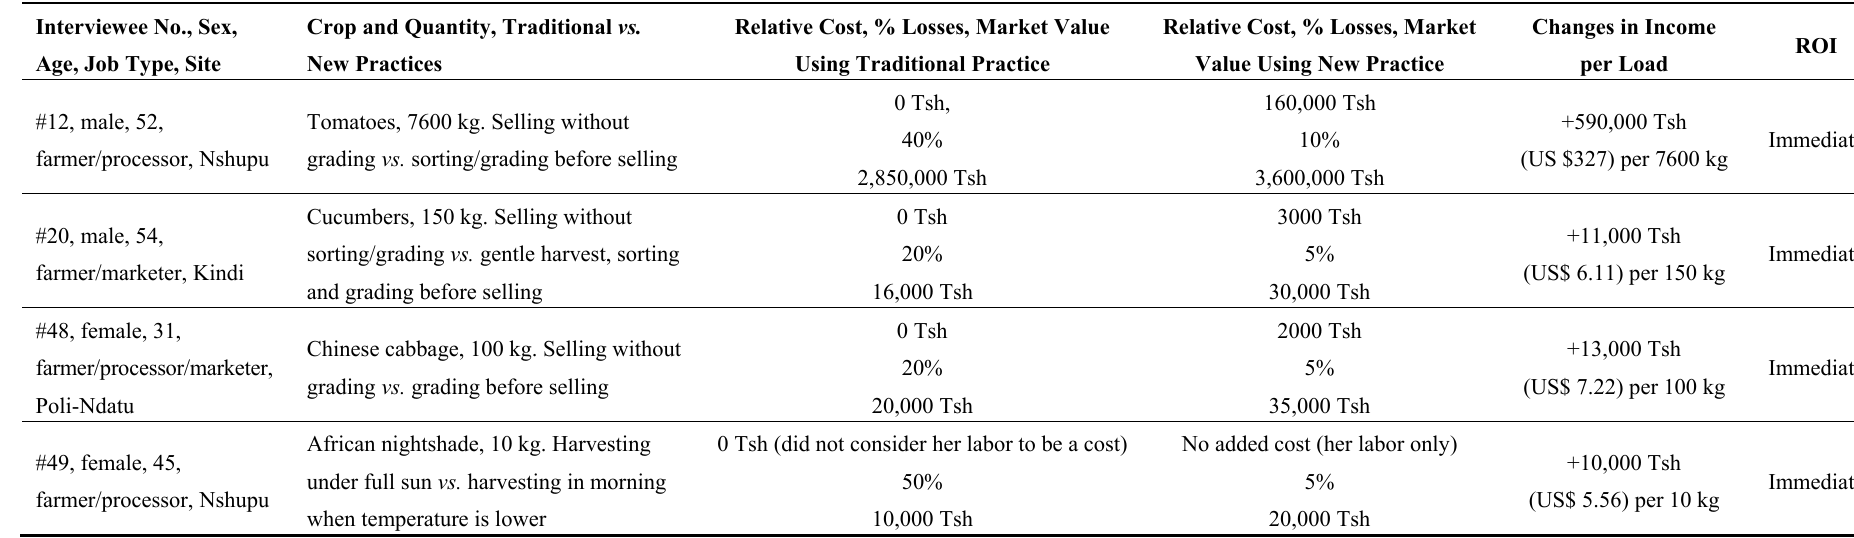
Table 4. Examples of relative costs and financial benefits of improved postharvest practices for fresh produce as reported in Tanzania. Interviewee No.,